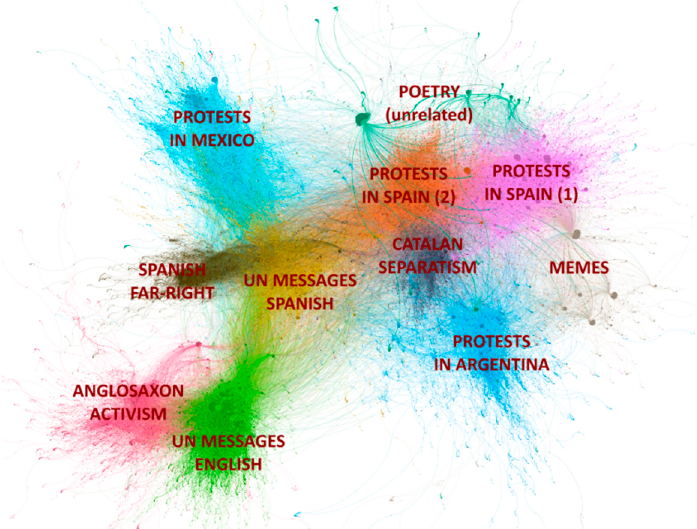
Figure 1. Interactions and dialogue related to #25N (2018). Source: own elaboration.